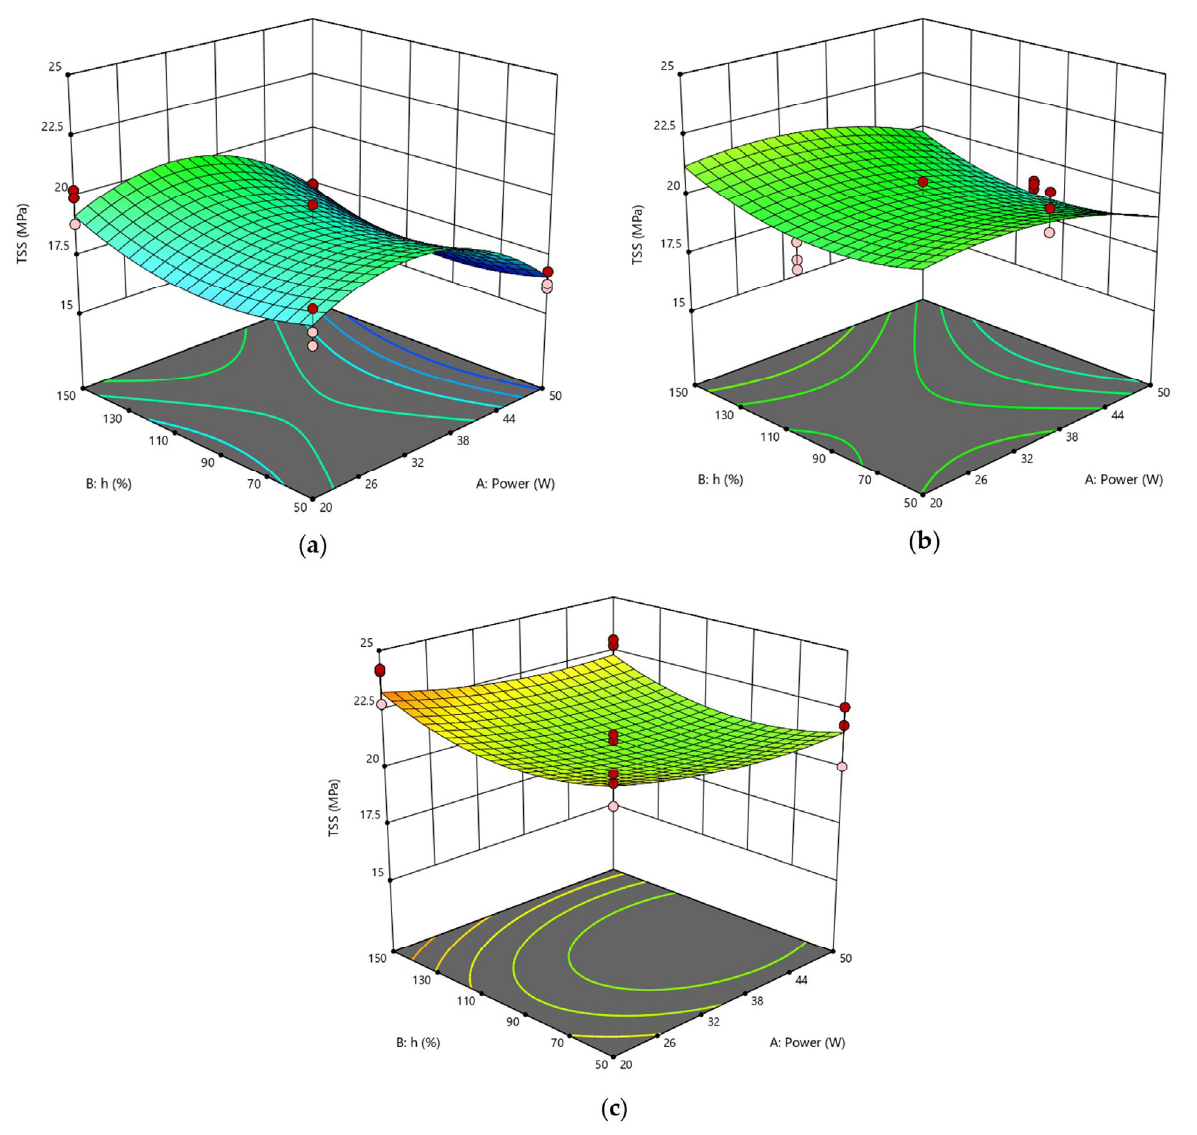
Figure 8. RSD 2: ( a ) O L = 50%; ( b ) O L = 100%; ( c ) O L = 150%.